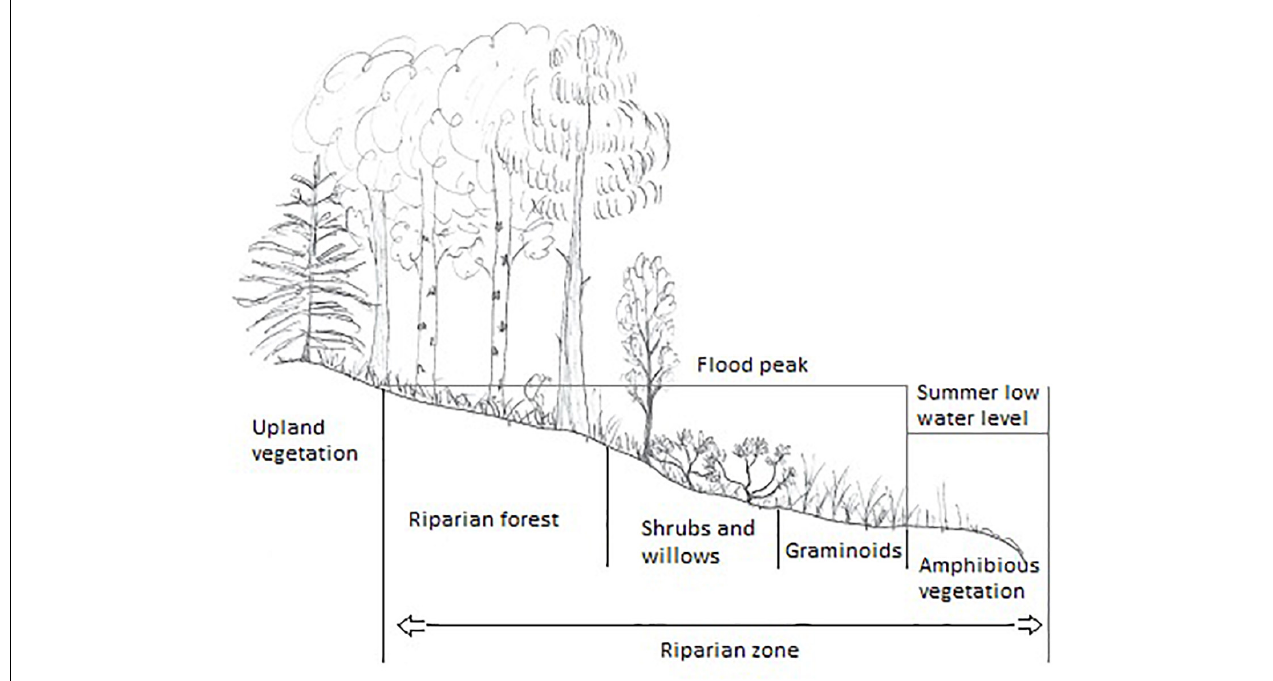
FIGURE 1 | Vertical zonation in boreal riparian zones. Image by Lovisa